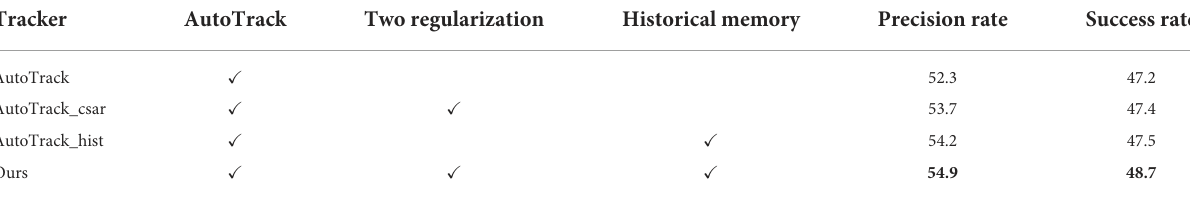
TABLE 2 The success rate and precision rate (percentage) of ablation experiments on UAV123. Tracker AutoTrack